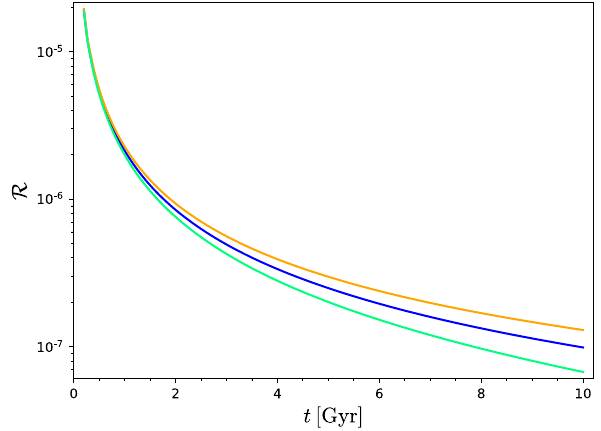
Fig. 10 Expansion scalar θ as a function of time. The quantity θ is evaluated at the overdensity – blue curve or at the underdensity – light- blue curve. For comparison, the expansion scalar of the EdS universe is plotted by red dashed